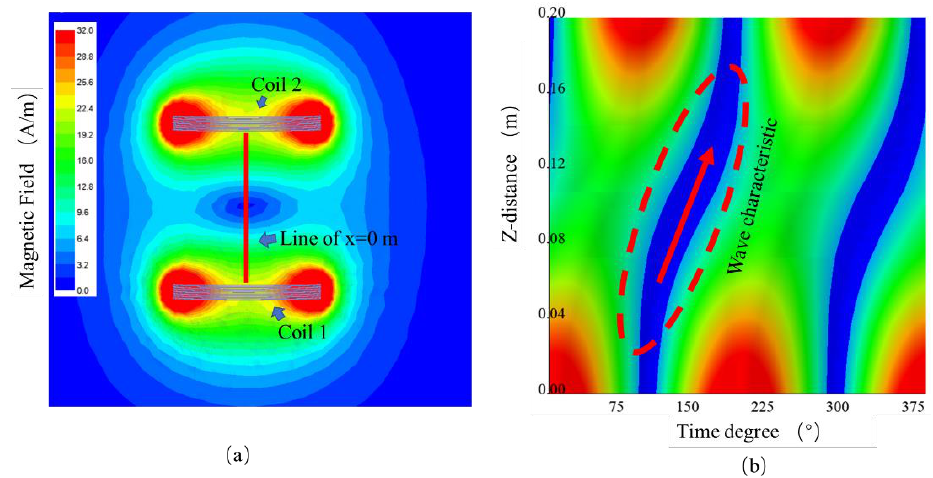
Figure 16. Simulation results: ( a ) magnetic field distribution at the time degree equal to 135°, ( b ) magnetic field on the line of x = 0 varying with time degrees. The minimum points of the simulation and theoretical analysis are plotted in Figure 17.